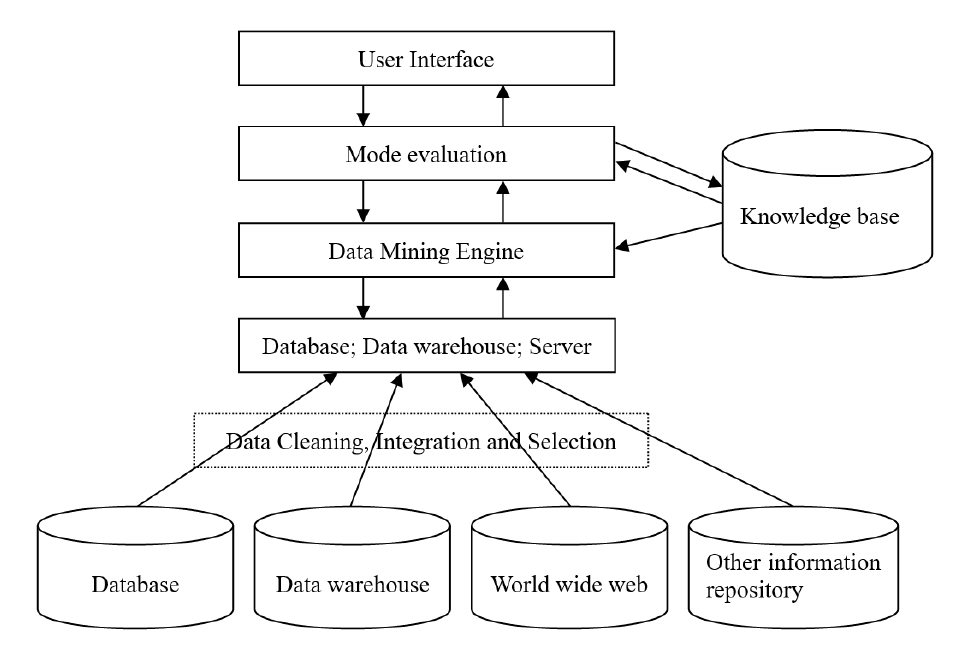
Fig. 2 Data Mining